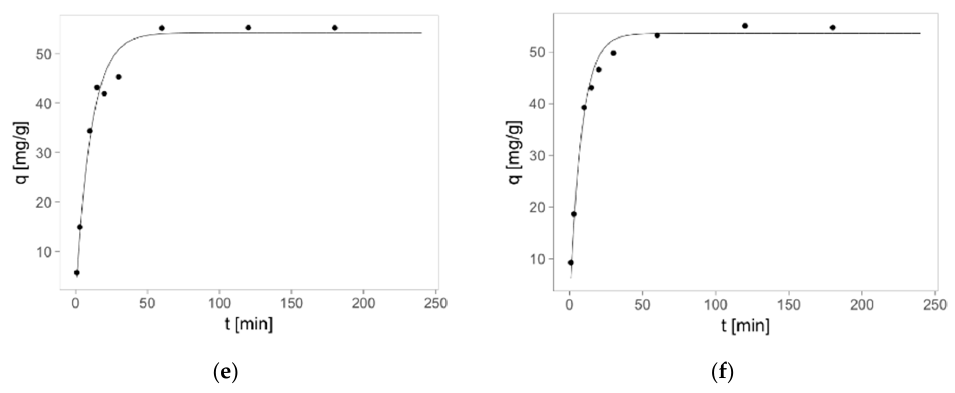
Figure 5. Adsorption kinetics of zinc(II) ions on PMMA—based sorbents: ( a ) PMMA1; ( b ) PMMA2; ( c ) PMMA3; ( d ) PMMA4; ( e ) PMMA5; ( f ) PMMA6 (pseudo-second order model). Mass of sorbent 0.01 g, initial concentration of metal: c = 30 mg/L, volume of solution: 0.02 L, pH = 6, temperature 22 ± 1 °C. Table 2. Calculated parameters of pseudo-second and pseudo-first order adsorption kinetics model of zinc(II) ions on PMMA-based sorbents.